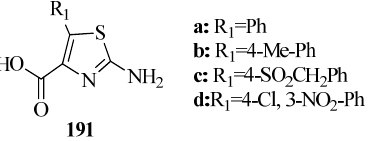
Figure 72. Structure of 4,5-trisubstituted thiazole derivatives.